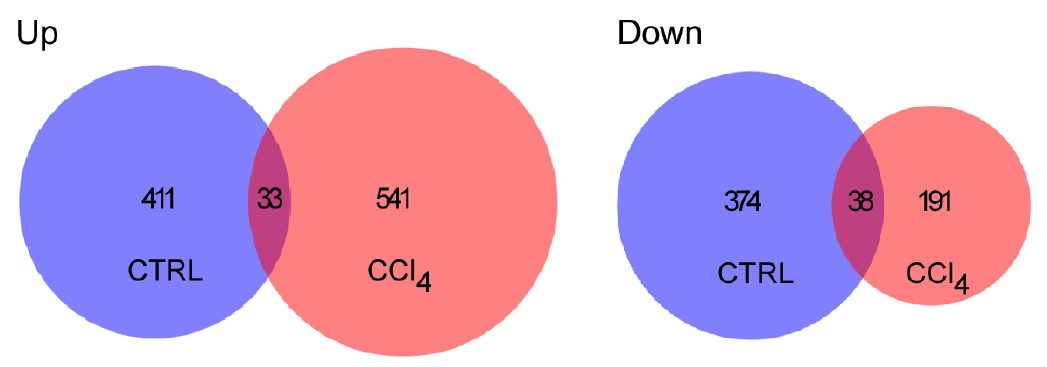
Figure 5. Analysis of gene expression patterns with microarrays of primary cultured hepatocytes stimulated with UTP, isolated from control and fibrotic mice. Venn diagrams representing number of transcripts up- and down-regulated in each condition after UTP stimulation, with the intersection representing the number of transcripts that changed in both settings.